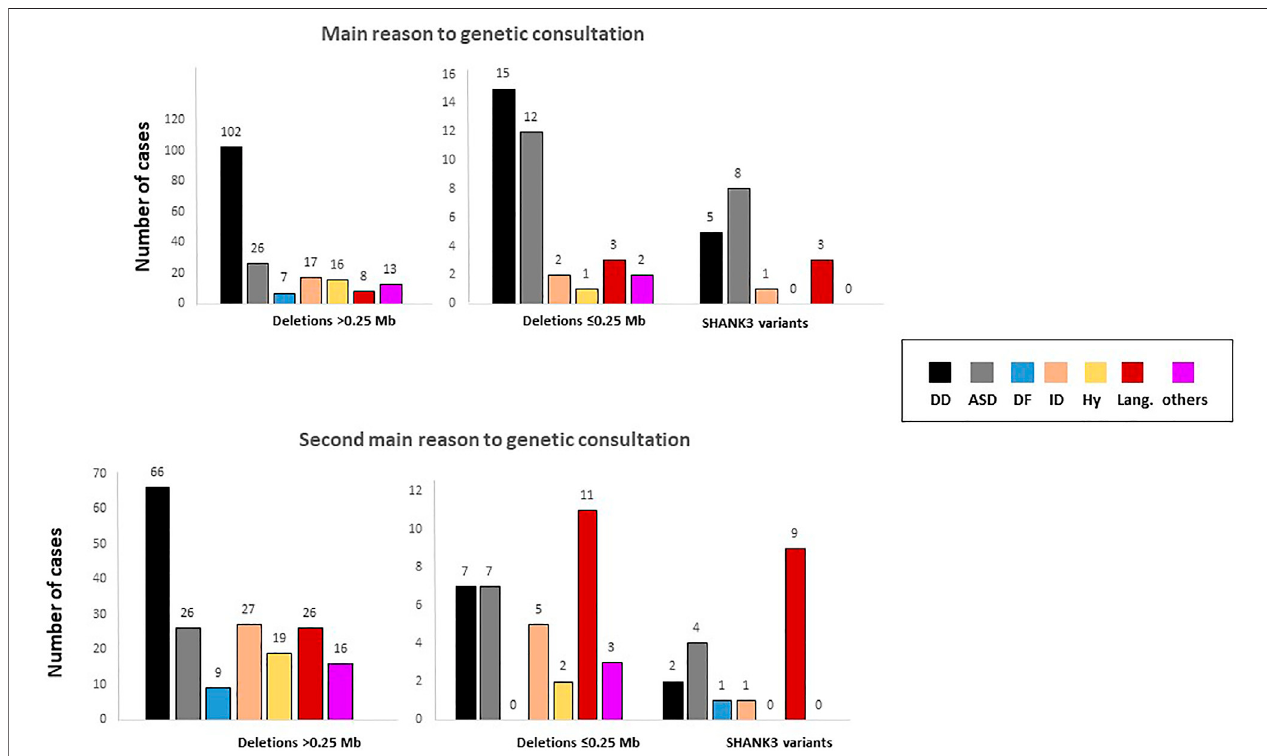
FIGURE 3 | Reasons for referral for genetic evaluation strati fi ed according to the type of genetic defect. Analyses were performed by one-way ANOVA. DD, developmental delay; ASD, autism spectrum disorder; DF, dysmorphic features; ID, intellectual disability; Hy, hypotonia; Lang., language.